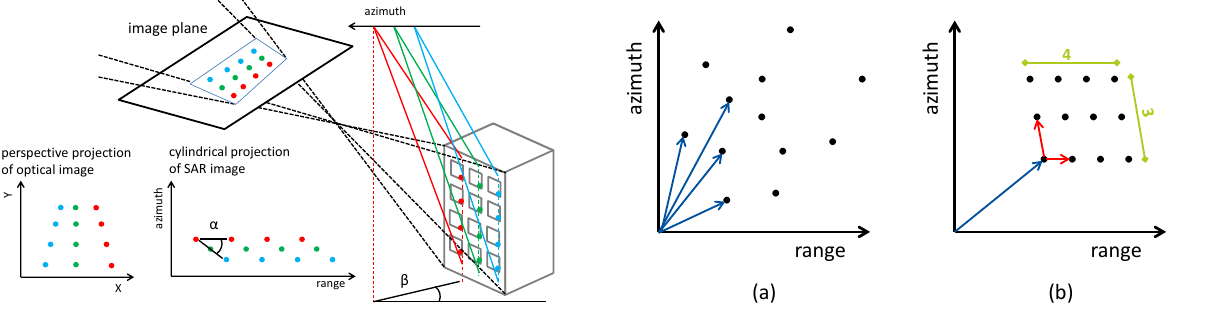
Figure 2: Sketch of the two different imaging geometries. Two important characteristics of the SAR mapping are exploited: a) Vertical aligned point scatterers are depicted into the same az- imuth coordinate and b) rectangular patterns are depicted into a sheared rectangular.